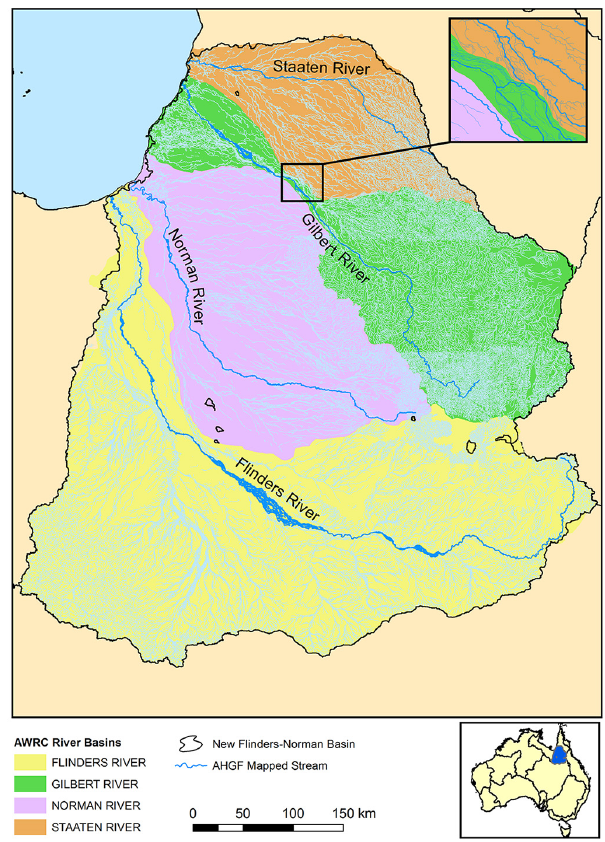
Figure 4. The Flinders–Norman Drainage Basin combining the catchment areas of the Norman, Flinders, Staaten and Gilbert rivers that are linked by floodplain distributaries. In contrast, the AWRC river basins delineate four separate river basins with boundaries drawn through the floodplain distributary channels. Note also the small areas of internal drainage.